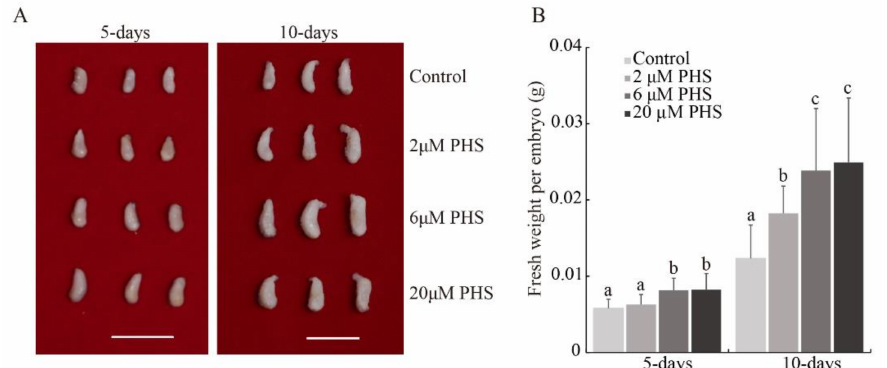
Figure 4. PHS (t18:0, phytosphingosine) increased embryo fresh weight. ( A ) Phenotype of PHS treated embryos after 5 and 10 days at different concentrations. Scale bars = 1 cm. ( B ) Fresh weight of PHS-treated embryos after 5 and 10 days at different concentrations. Values represent means ± SD ( n ≥ 24). Different letters above the bars indicate significant differences at the p = 0.05